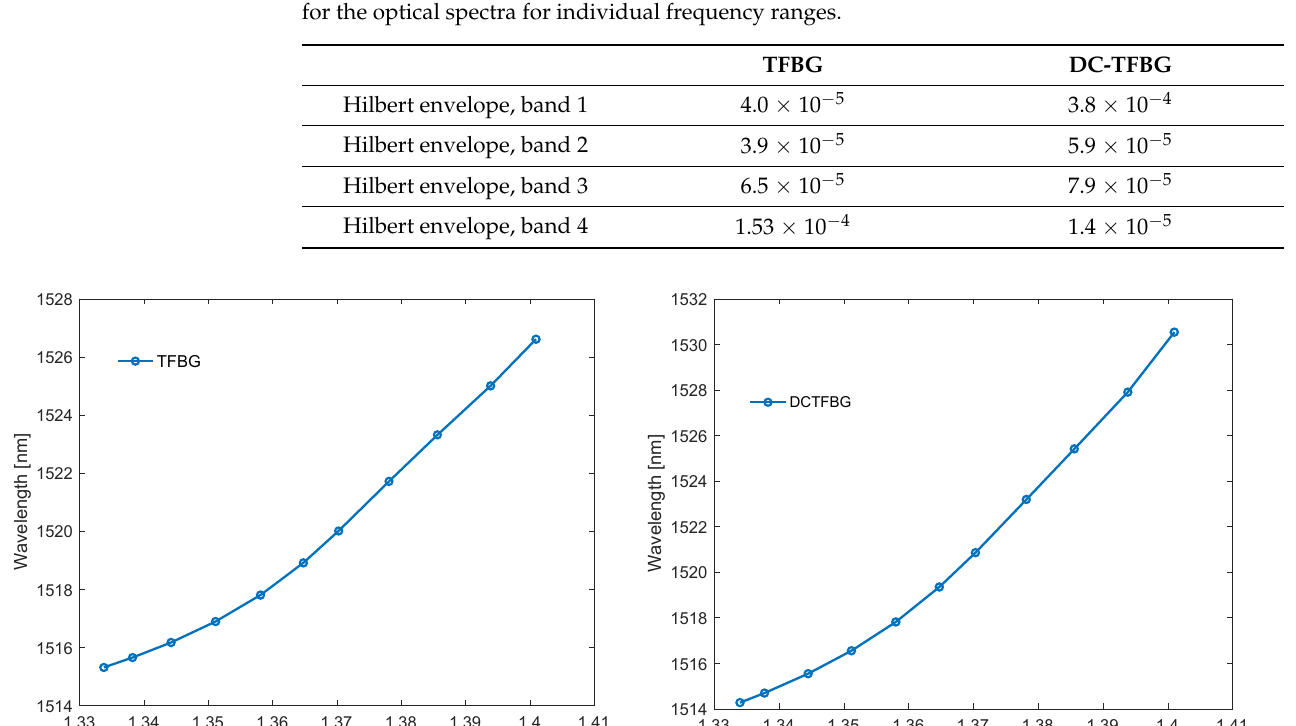
Figure 15. Change in the wavelength of the centre of gravity of the TFBG optical spectrum after band filtration for band 1 and for DCTFBG for band 2 filtration.